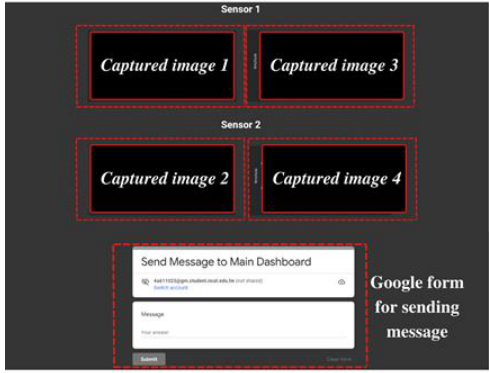
Figure 9. Website appearance of CPMA.